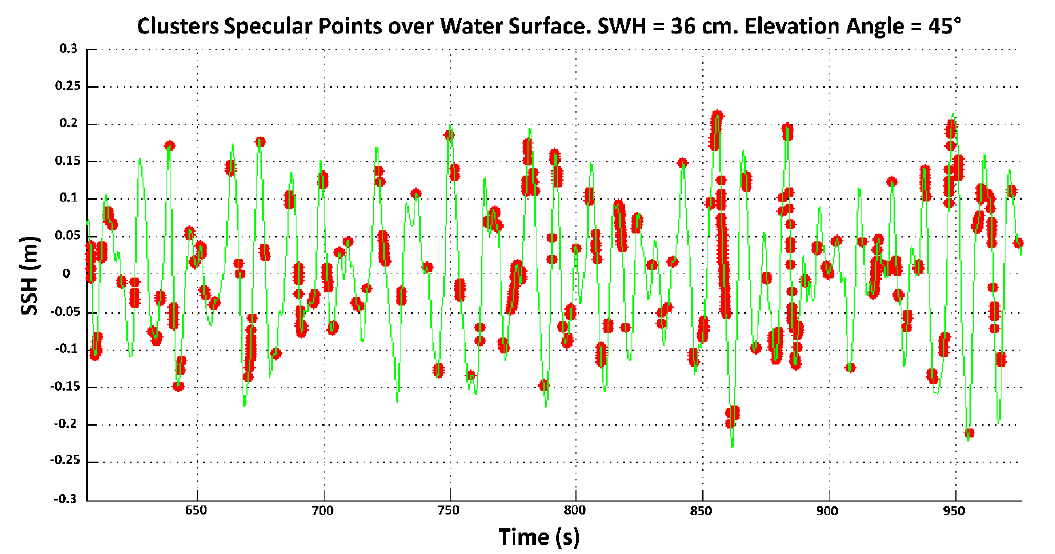
Figure 5. Clusters of specular points distributed over the water surface profile as computed using the temporal series of data provided from the HR Wallingford wave probe monitor for a SWH = 36 cm and θ = 45°. SSH, sea surface height. e